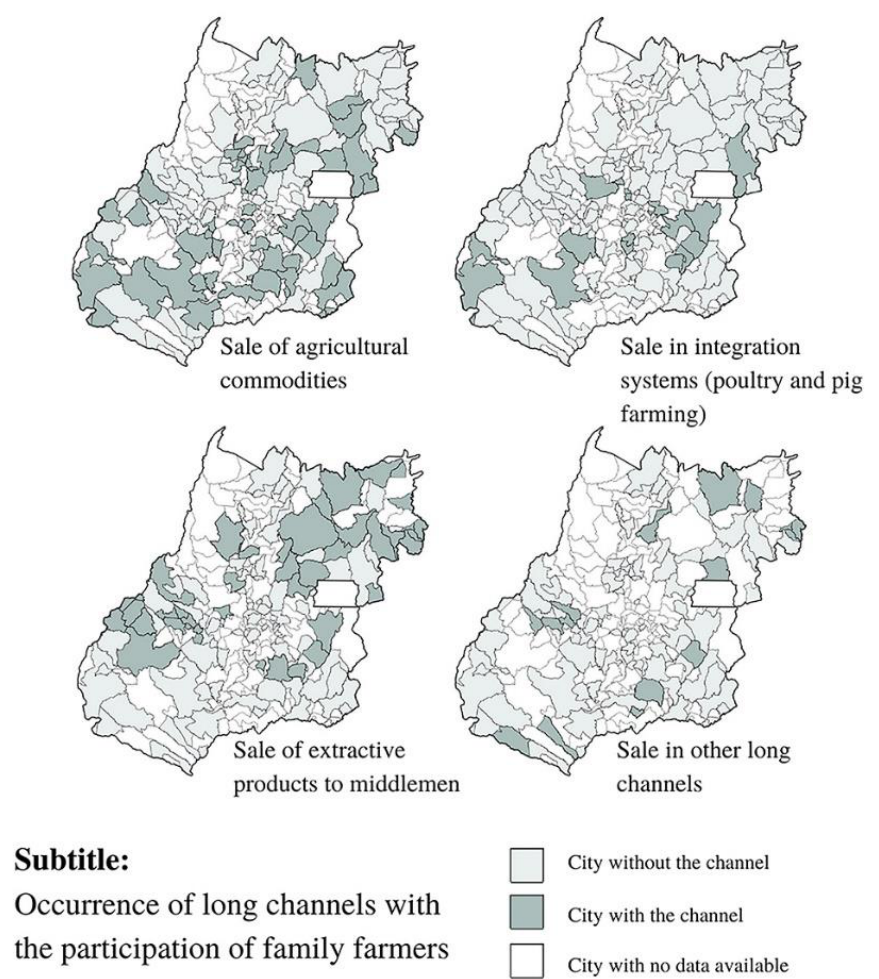
Figure 3. Presence of long sales channels with family farmers’ participation (sale of agricultural commodities, sales in integration systems, sales of extractive products to middlemen, and sales in other long channels).